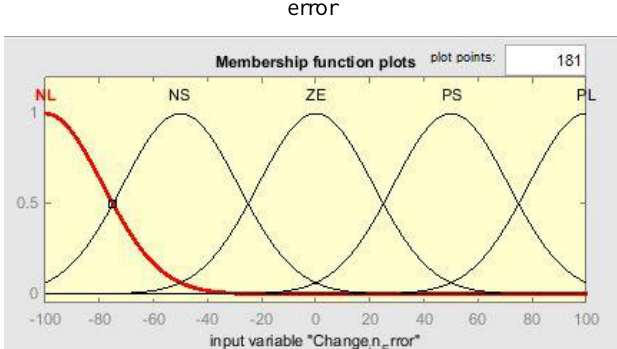
Fig. 7. Membership function plot for input variable i.e. error